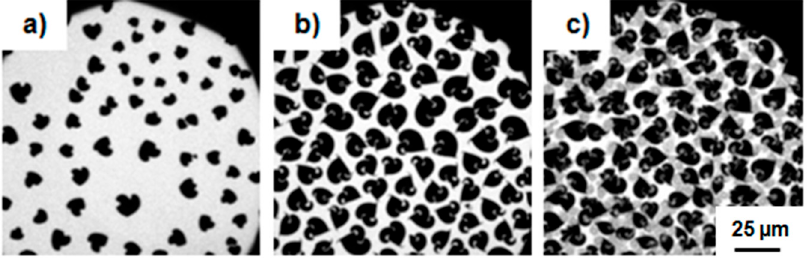
Figure 7. Epifluorescence microscopy images of monolayers of DPPC/ 6 at a ratio of 99:1 at the air–water interface at 20 °C. The images were recorded at constant compression of the spread monolayer at the following surface pressures: ( a ) 5.3, ( b ) 7.3, ( c ) 7.9 mN·m − 1 .